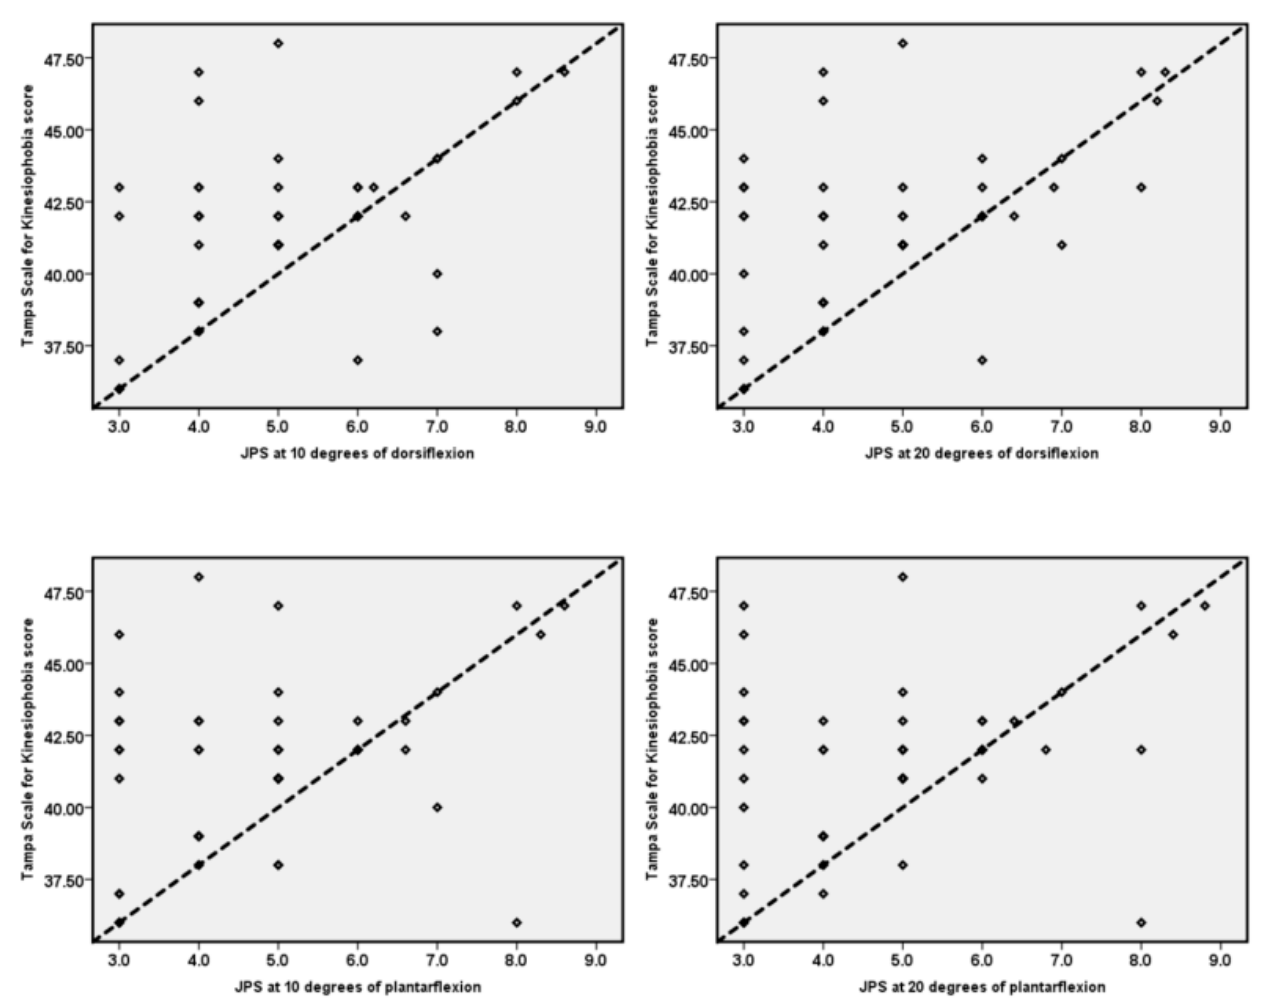
Figure 3. Relationship between TSK scores and ankle joint position sense. Kinesiophobia showed a significant positive correlation (moderate) with the ankle JPS in dorsiflexion (10 ◦ : r = 0.51, p < 0.001; at 15 ◦ : = r = 0.52, p < 0.001) and plantarflexion (10 ◦ : r = 0.35, p = 0.009; at 15 ◦ : = r = 0.37, p = 0.005). Kinesiophobia also showed significant positive (moderate) correlation with postural control variables (ellipse area: r = 0.44, p = 0.001; Anterior–Posterior sway: r = 0.32, p = 0.015; Medial–Lateral sway: r = 0.60, p <